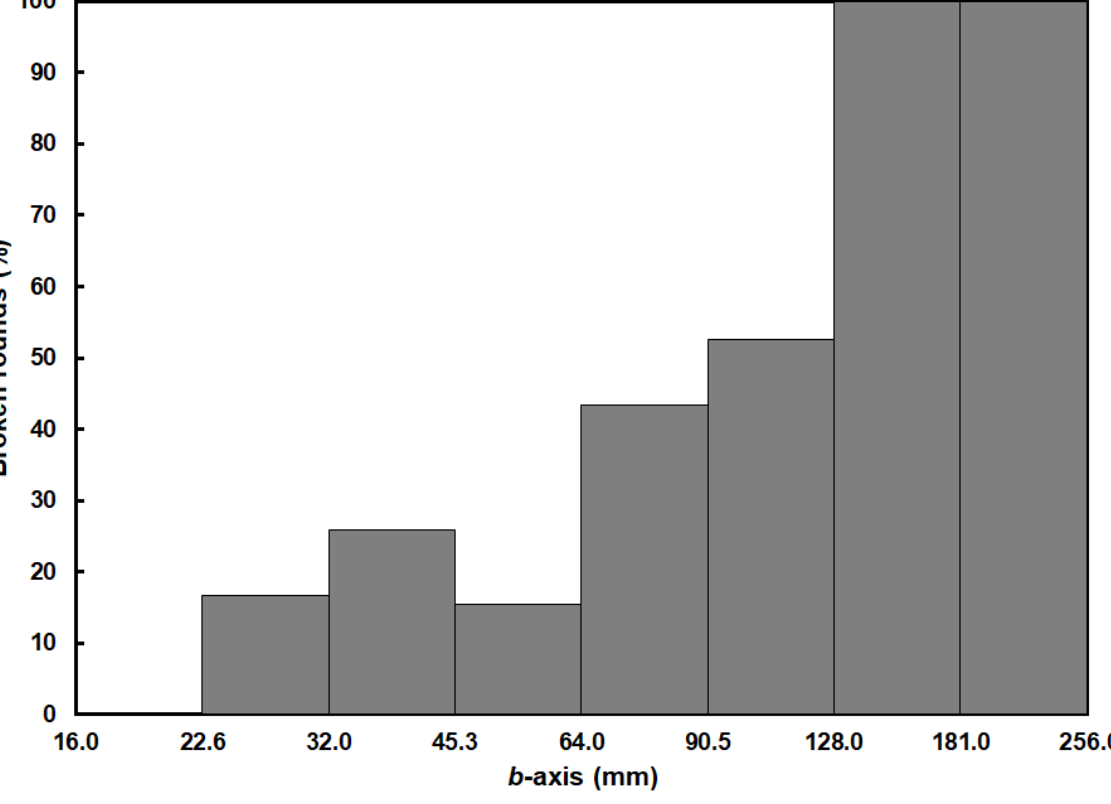
Figure 6. The incidence of broken rounds as a function of particle size in fluvial gravels of Navilawa Monzonite at Station 1 in the Sabeto River of western Viti Levu, Fiji.